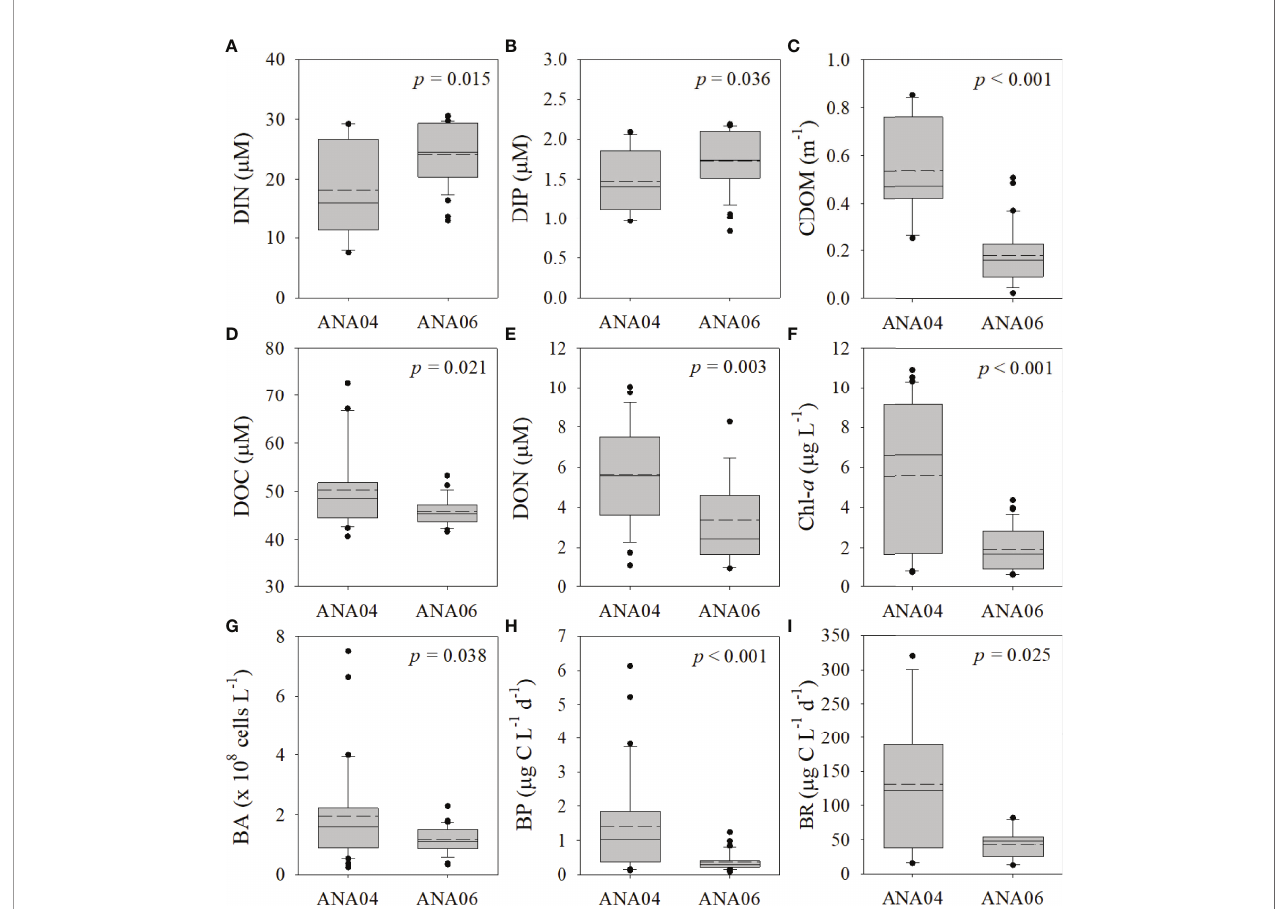
FIGURE 3 | Box plot of chemical and biological parameters within the upper 100 m of the water column in ANA04 and ANA06. Dissolved inorganic nitrogen (DIN) (A) , dissolved inorganic phosphate (DIP) (B) , chromophoric dissolved organic matter (CDOM) (C) , dissolved organic carbon (DOC) (D) , dissolved organic nitrogen